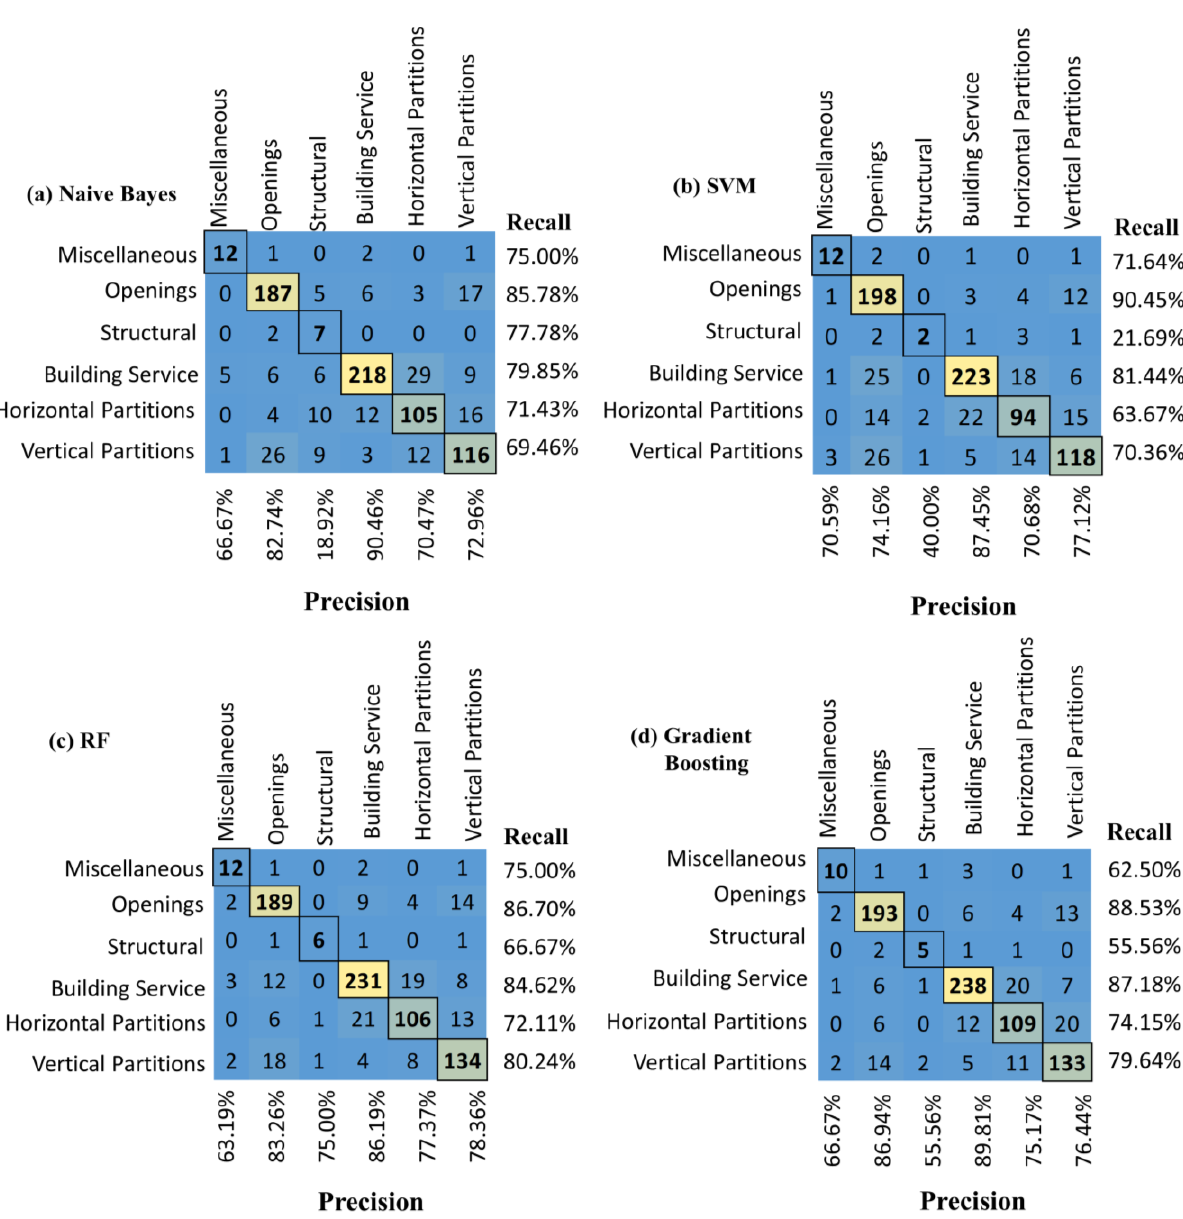
Figure 10. Confusion matrices of ( a ) Naïve Bayes, ( b ) SVM, ( c ) RF, and ( d ) Gradient Boosting.